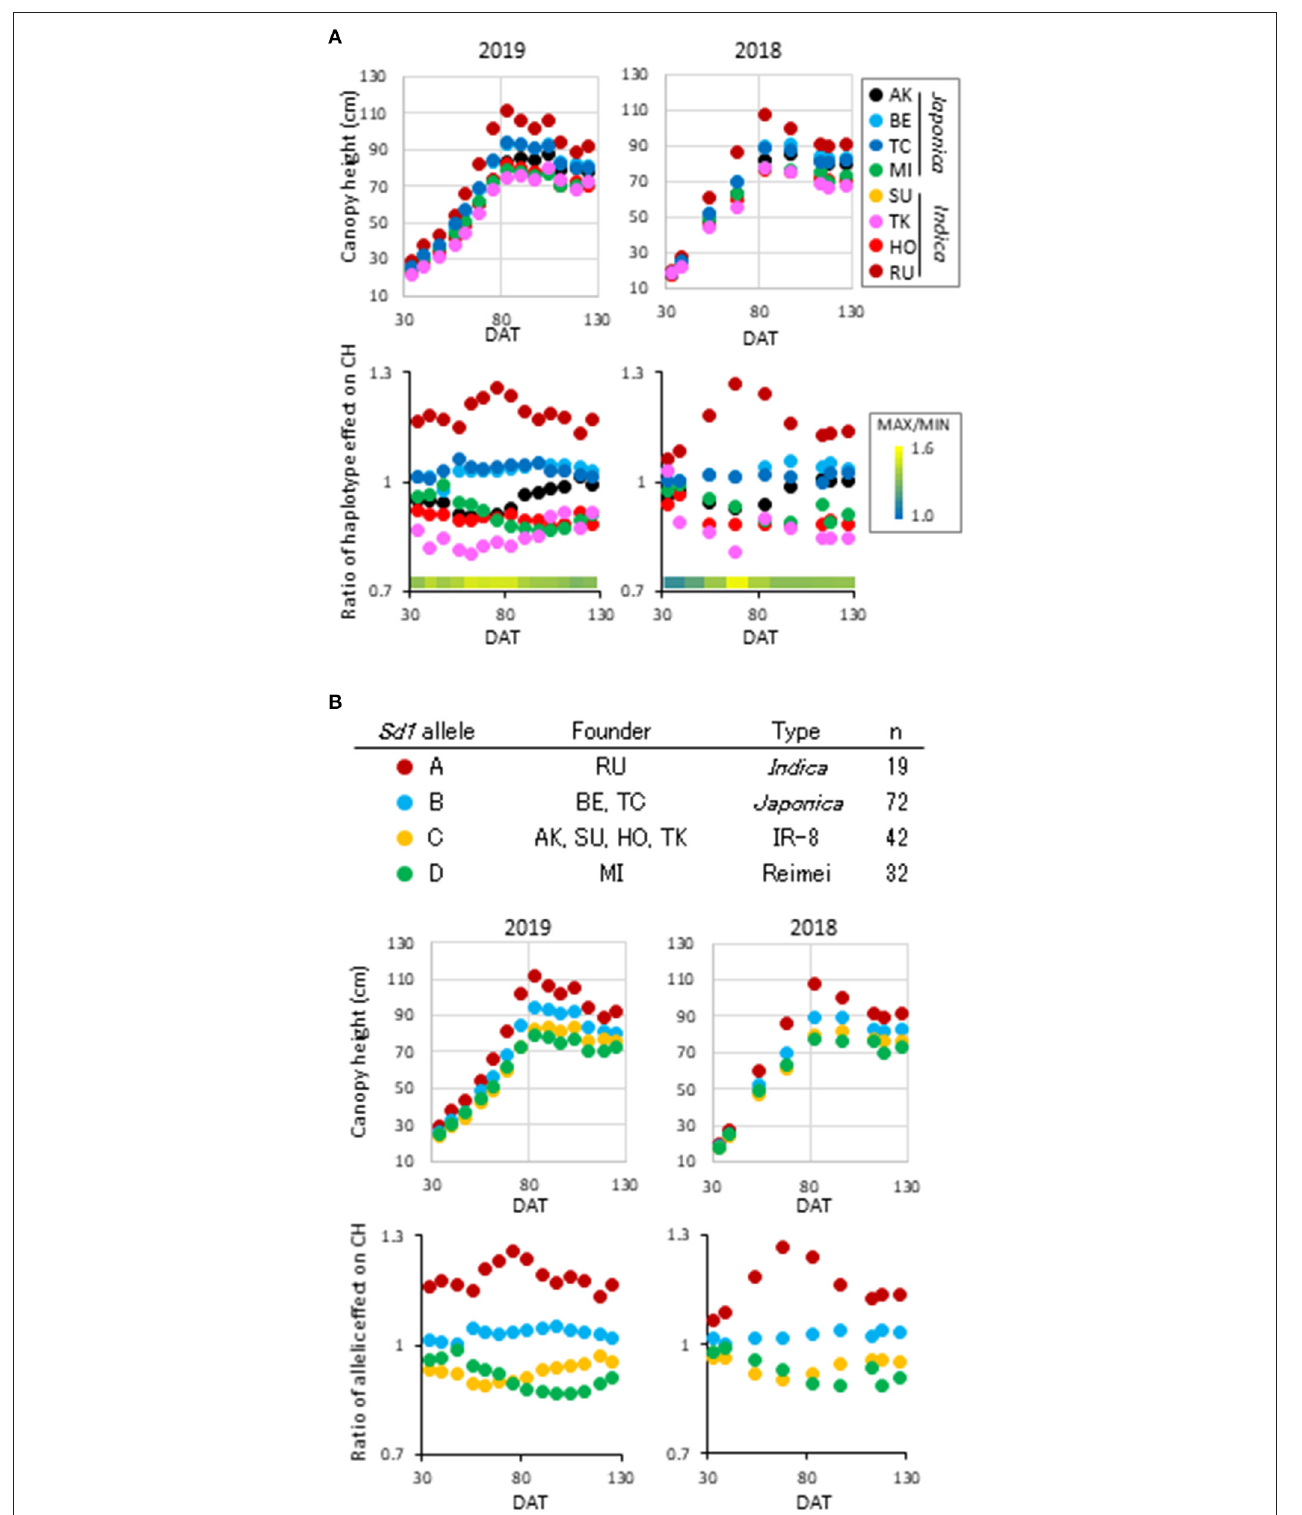
FIGURE 2 | Haplotype effect on canopy height at qCH1-4 . (A) Time-course pattern of haplotype effect on CH at qCH1-4 . Average phenotypic values of the eight haplotypes (top) and ratio of the haplotype effect to average of the JAM lines (bottom) at each DAT in 2019 (left) and 2018 (right) are plotted. (B) Time-course pattern of Sd1 allelic effect on CH at qCH1-4 . Four Sd1 alleles were included in the eight founders (top). Average phenotypic values of the four alleles (middle) and ratio of the allelic effect to average of the JAM lines (bottom) at each DAT in 2019 (left) and 2018 (right) are plotted.